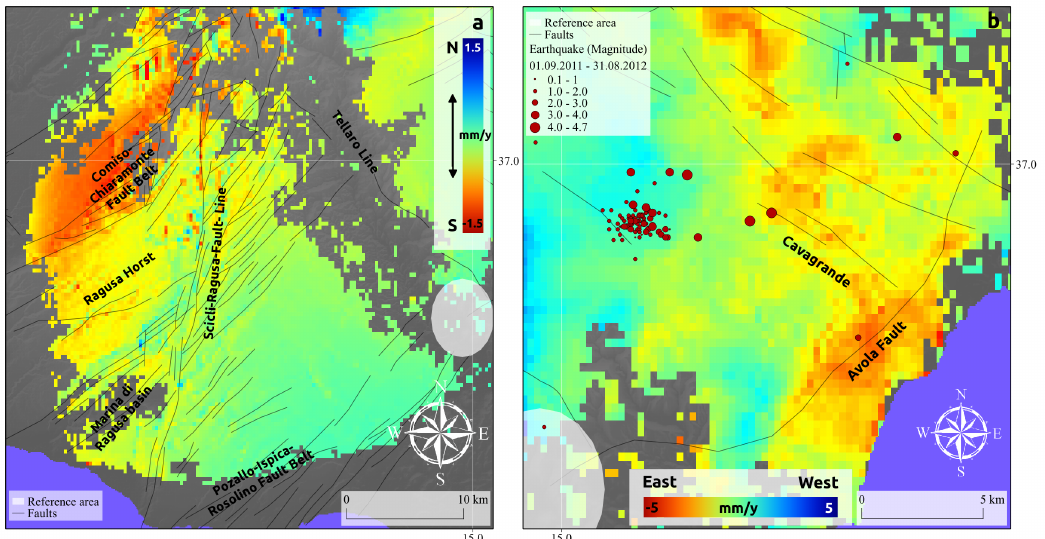
Figure 7. Zoom-in on the ( a ) north-south velocity field along the Scicli-Ragusa fault; and ( b ) the east-west velocity field of the area around the Avola fault with the overlay of the earthquakes associated with 2011/2012 seismic swarm event